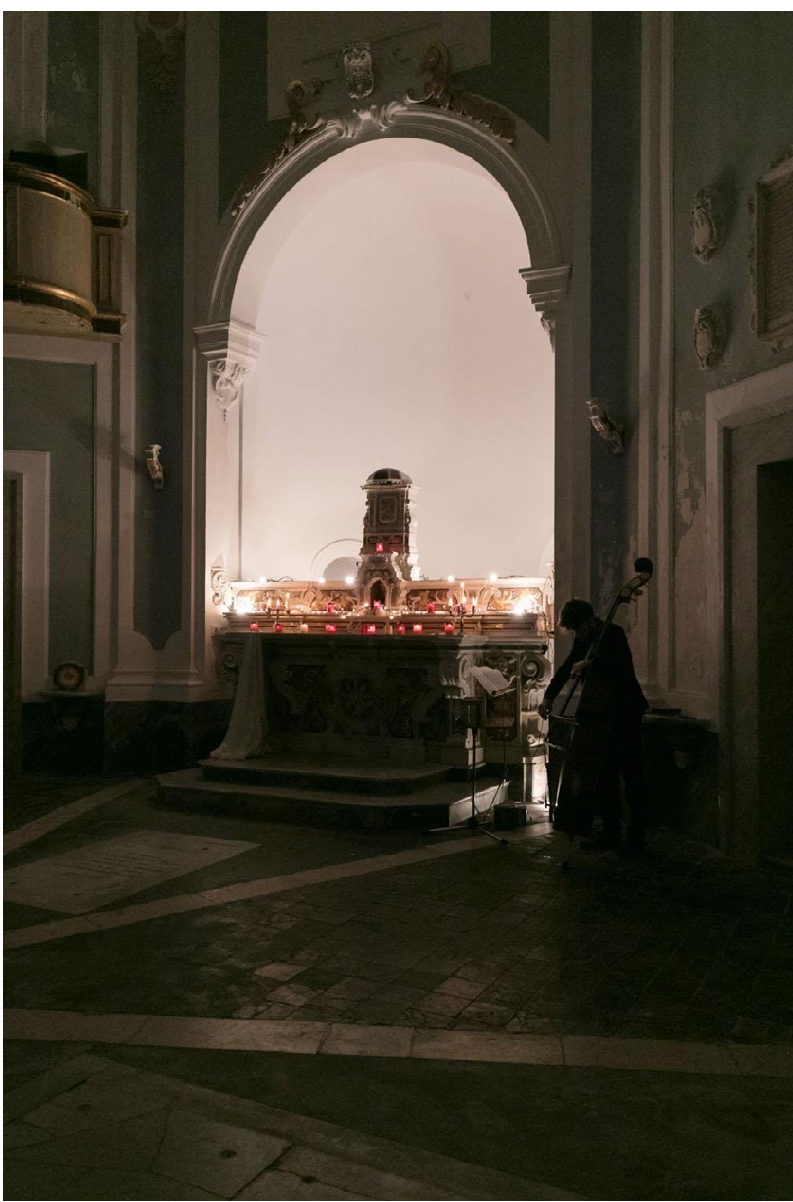
Church of San Sebastiano dei Morti—Blam Ludovica La